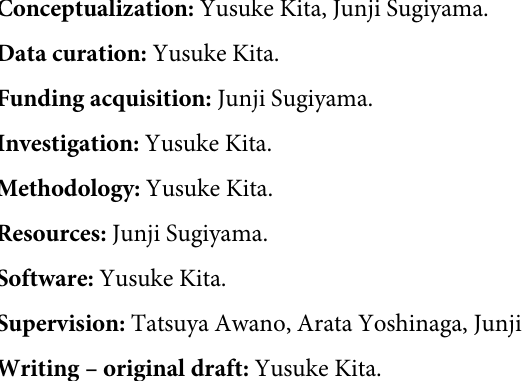
S3 Fig. X-ray fiber diffraction diagrams obtained from the identical sample observed in this study. S4 Fig. Normalized intra-annual transitional behaviors of a portion of the anatomical